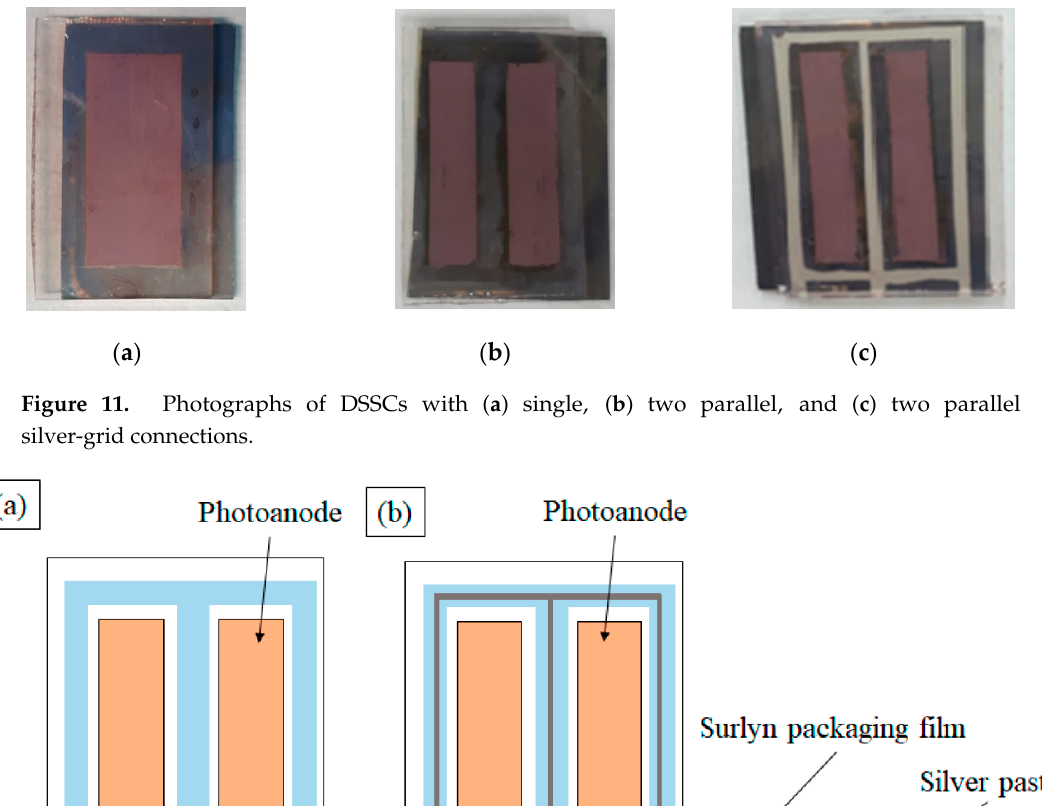
Figure 10. J-V characteristics of different connections and active areas in DSSCs.